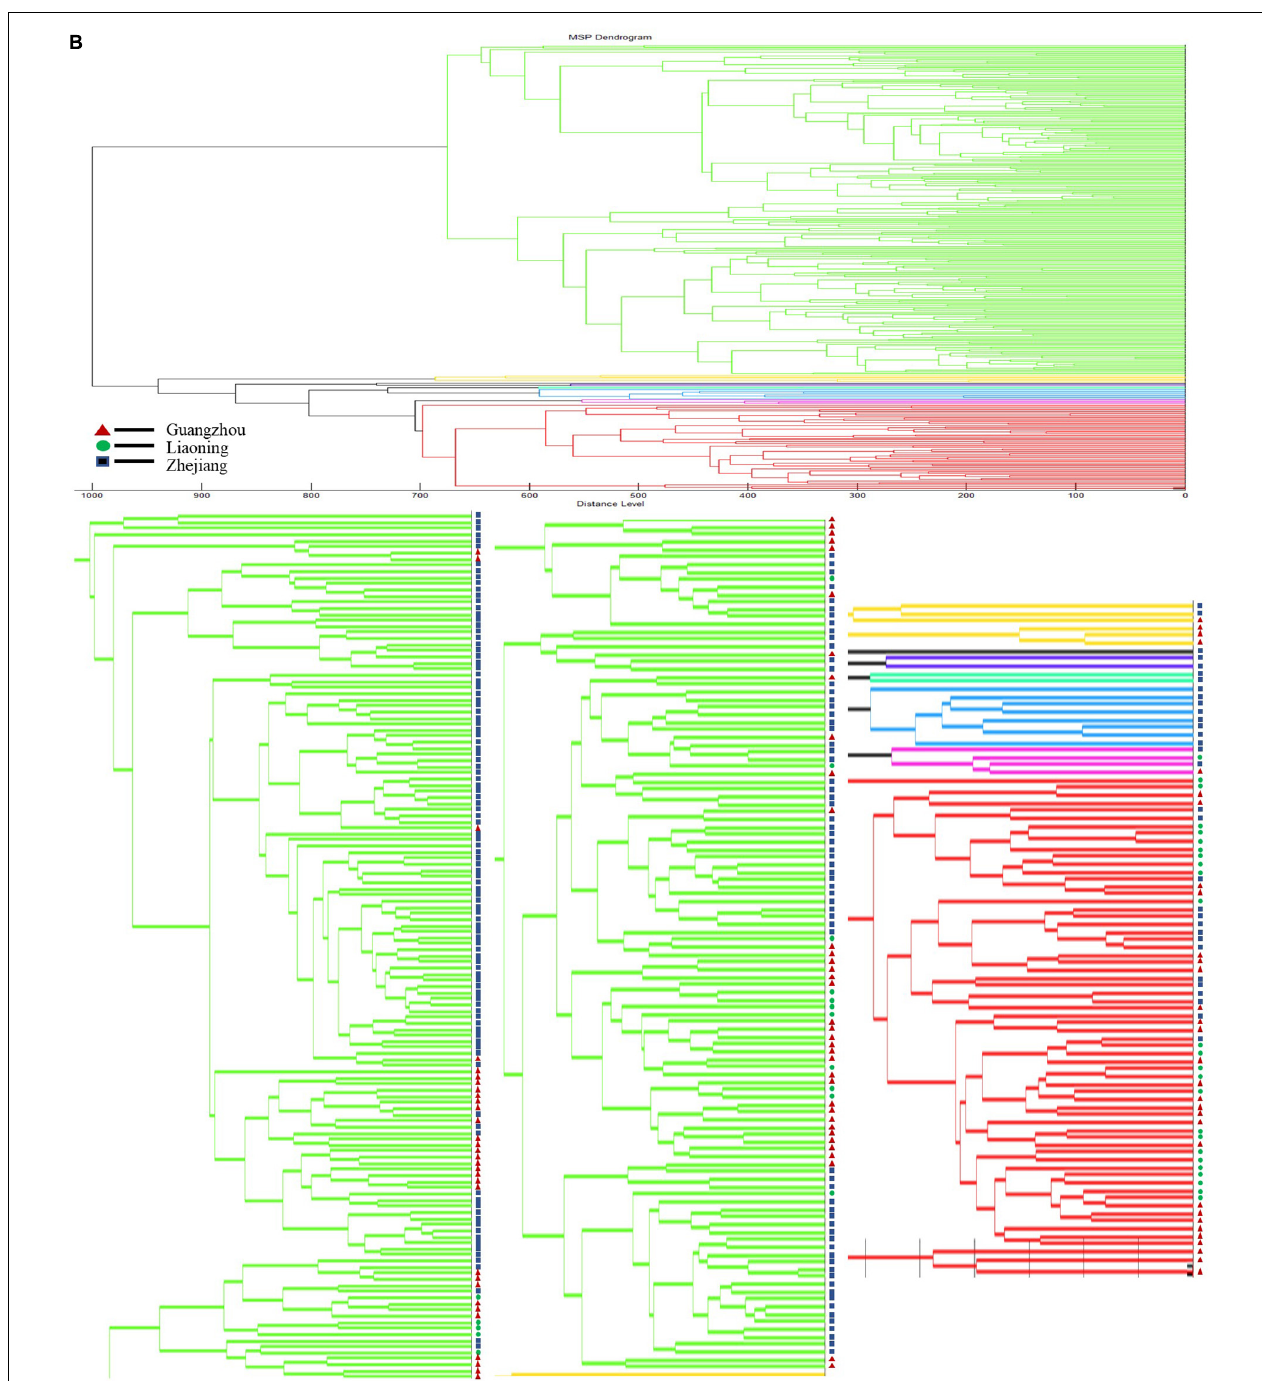
FIGURE 7 | Dendrogram analysis of strains in different regions. (A) Dendrogram analysis of V. vulnificus in different regions. (B) Dendrogram analysis of V. parahaemolyticus in different regions.